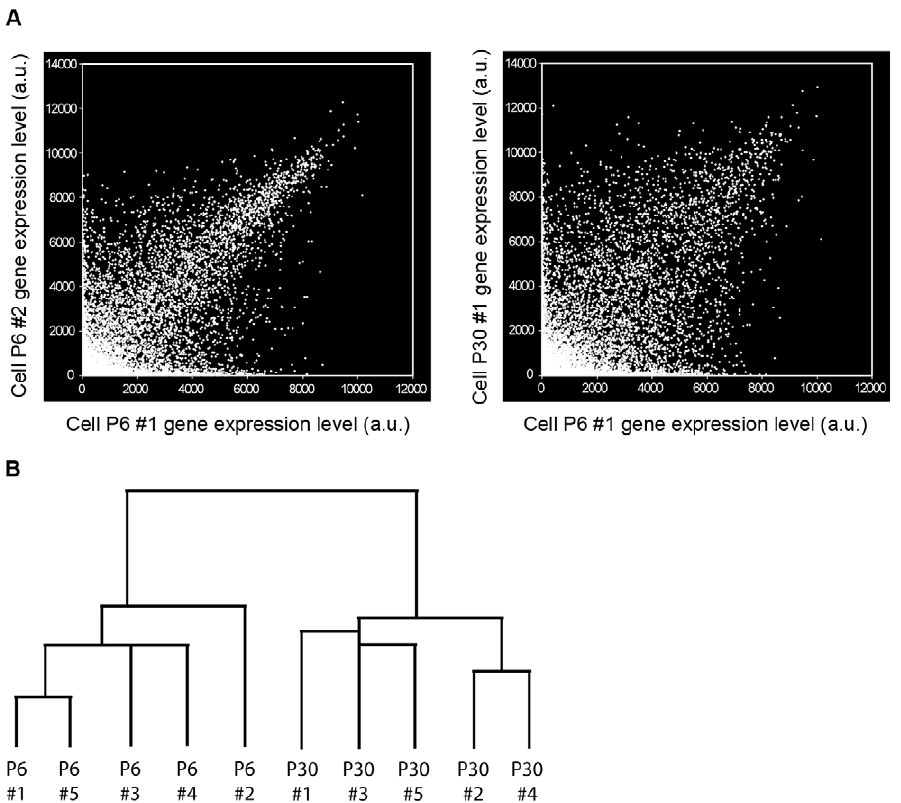
Figure 3. Single cell RT-PCR of individual Bergmann glia is sufficiently accurate for comparison of expression profiles by age. A , Scatter plots of raw gene expression level compared between two cells from the same age (P6-1 vs. P6-2; left panel) and between ages (P6-1 vs. P30- 1; right panel) (a.u.: arbitrary units). The samples from the same age show high similarity (mean within-age correlation coefficient=0.81), which is comparable to what is reported between individual cells of a glioblastoma cell line (0.86) [25]. The high level of concordance between samples of the same age increases the reliability of comparisons between ages. Samples of different ages are significantly more divergent (mean P6 vs. P30 correlation coefficient=0.66). B , Dendrogram and sample clustering of individual Bergmann glia. Unsupervised hierarchical clustering based on overall gene expression profiles reveals two distinct clusters corresponding to the two ages, P6 and P30. This suggests that the samples from the two ages do indeed represent two statistically distinct populations suitable for valid